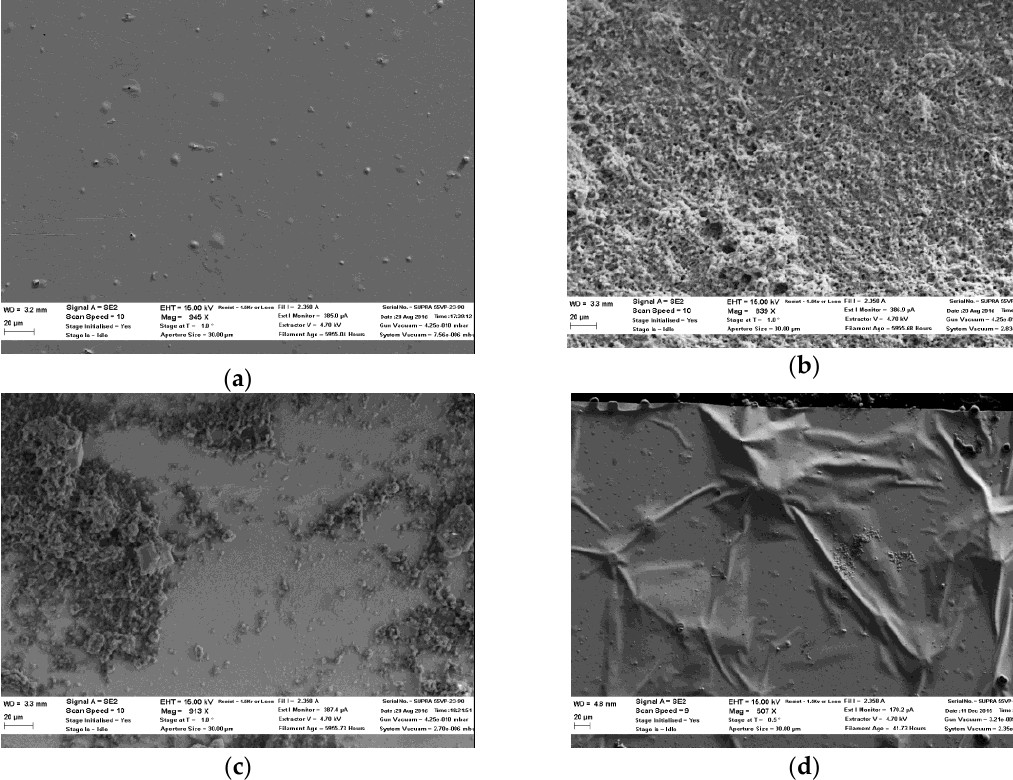
Figure 11. ( a ) SEM photo of the Au film before being loaded with enzymes. ( b ) SEM photo showing the structure of the cured lactate protein on the Au surface. ( c ) SEM photo of the Au sensor after being used for three weeks. The amount of the enzyme protein was decreased. ( d ) SEM photo of the bumpy Au surface after the probe was used for a month.